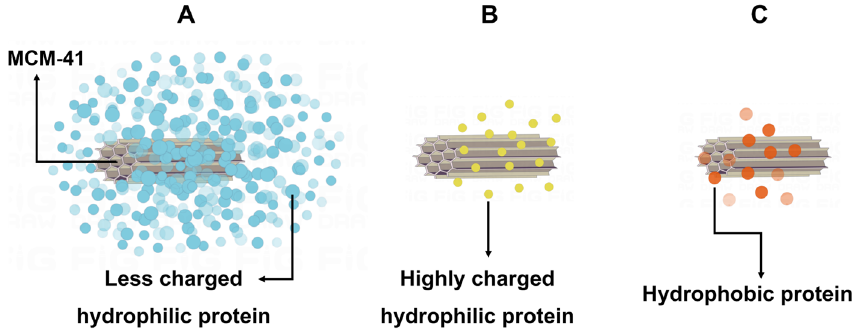
Figure 6. ( A ) The strong interaction pattern. ( B ) The moderate interaction pattern. ( C ) The weak interaction pattern. interaction